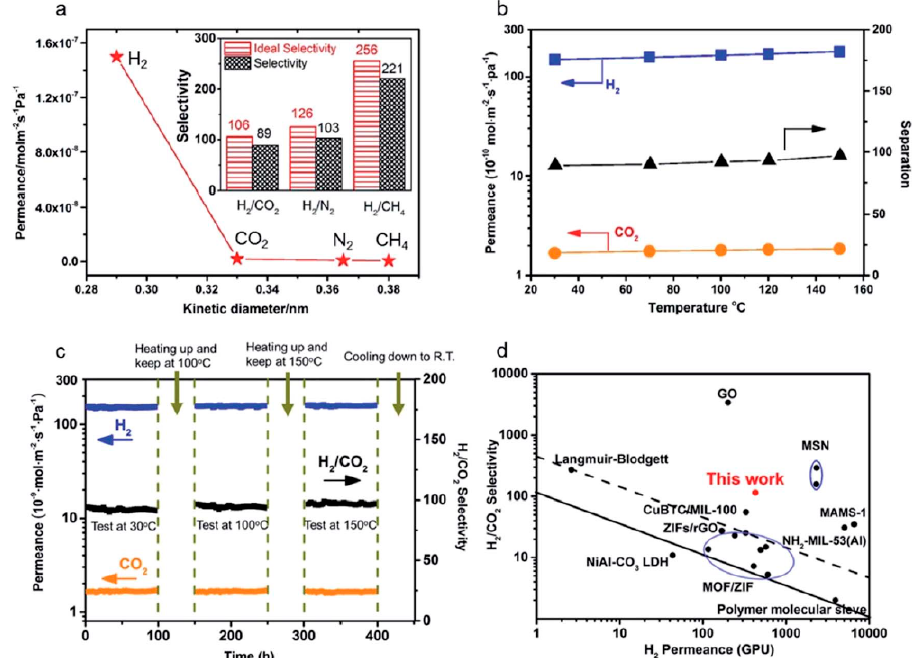
Figure 46. ( a ) Single gas permeances of the M-9 membrane (inset: ideal separation factors for single gases and separation selectivities for binary gas mixtures for H 2 over CO 2 , N 2 , and CH 4 ); ( b ) permeances of binary gas mixtures as a function of temperature difference; ( c ) long-term operating stability of the M-9 membrane for the separation of an equimolar H 2 /CO 2 mixture in the range of temperatures from 30 to 150 ◦ C at 0.1 MPa; and, ( d ) comparison of our M-9 membrane with the reported molecular sieve membranes for the separation of H 2 /CO 2 mixtures. The black solid line represents the 2008 upper bound of polymeric membranes for H 2 /CO 2 . The black dashed line represents the 2010 upper bound of microporous inorganic membranes for the separation of H 2 /CO 2 mixtures. (adapted with permission from ref.